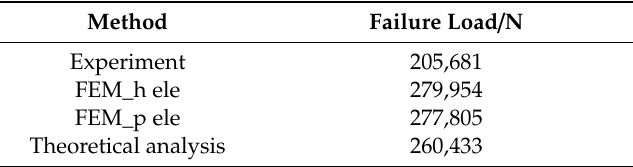
Table 4. Buckling failure